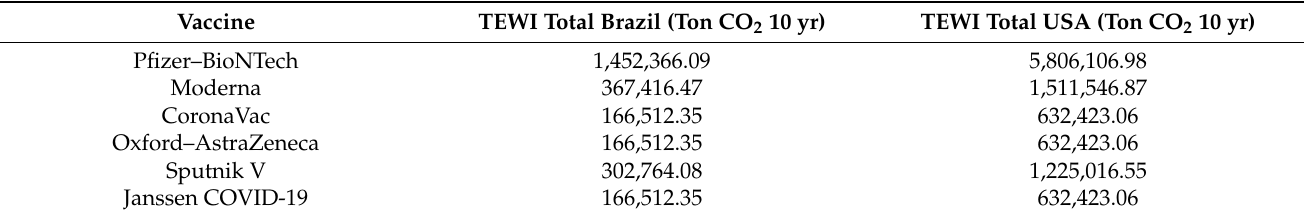
Table 7. Worldwide Vaccine TEWI.